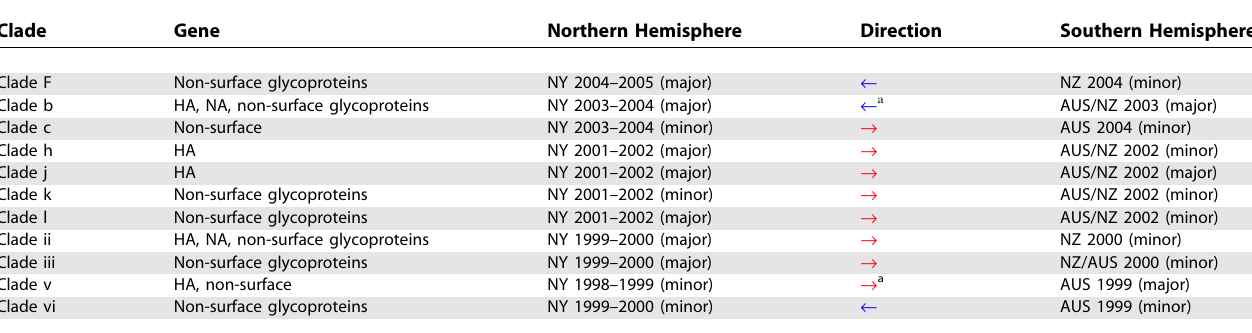
Clade letters/roman numerals refer to Figures 2–4. Red arrows signify north-to-south migration events; blue arrows denote south-to-north migration. Viral populations are classified as belonging to the major clade of viruses that circulated each season in a given locality or to a minor clade. a The additional presence of global strains in a clade. AUS, Australia; NY, New York state; NZ, New